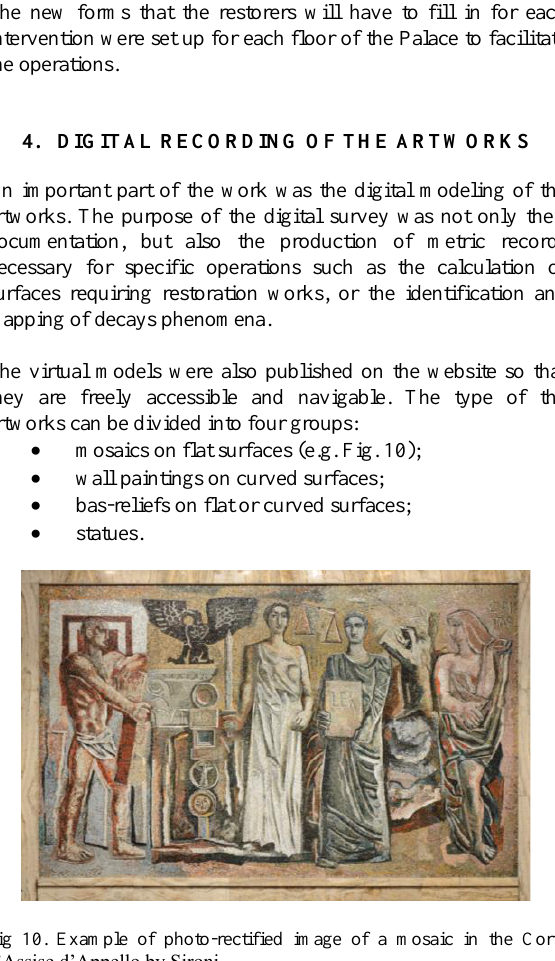
Fig 9. One of the censored artworks, which are therefore incomplete, by Carlo Pini.